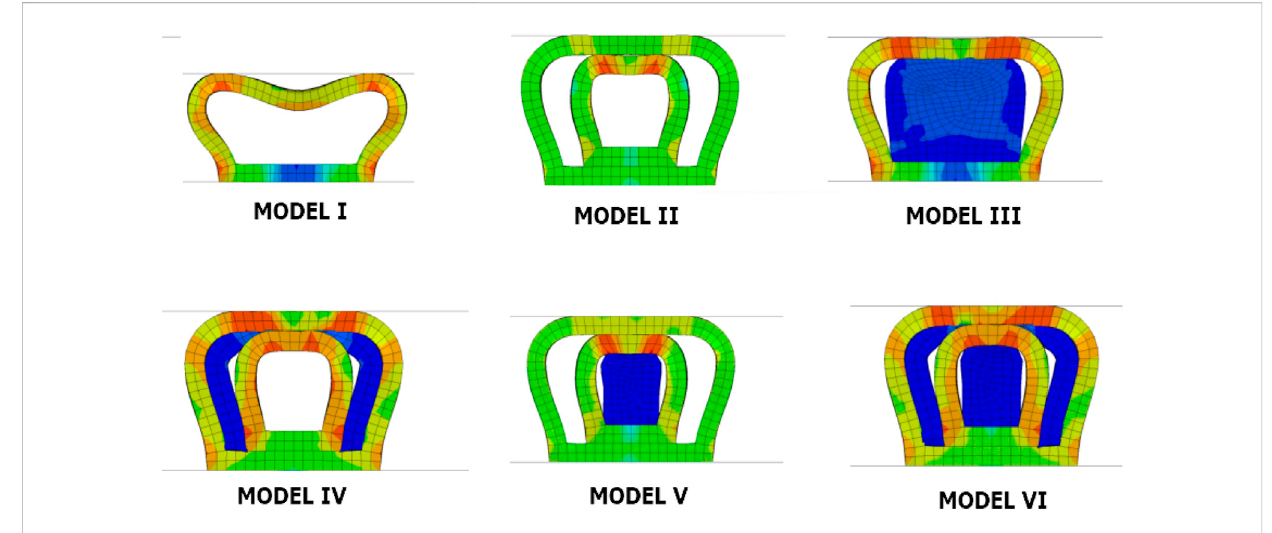
FIGURE 12 Deformation pattern of different structures under quasi static